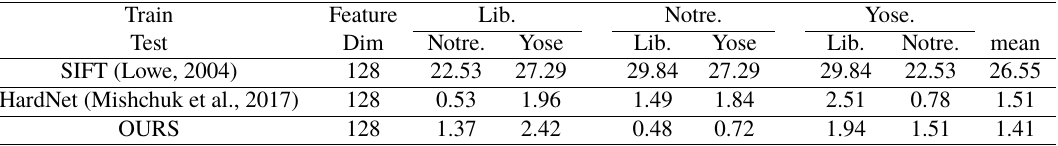
Table 3. Descriptor evaluation result (FPR at 95%TPR, unit %) on Brown dataset (Brown et al., 2011). Notre. = Notre Dame ; Lib.= Liberty ; Yose.= Yosemite . OURS represents the solution presented in this paper, which is a refinement of HardNet.